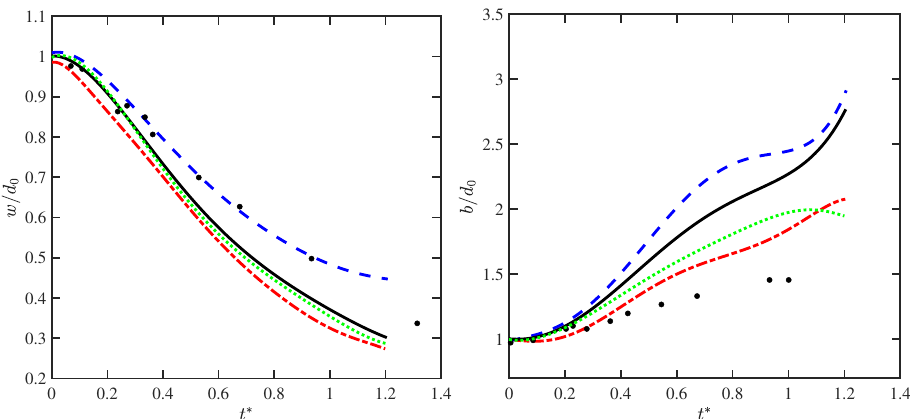
Figure 6. Time history of the normalized centerline width ( left ) and cross-stream breadth ( right ) of the water column: CFD II (green dotted line) and CFD III (black solid line), compared to reference numerical solutions (blue dashed and red dashed-dotted lines) and experimental data